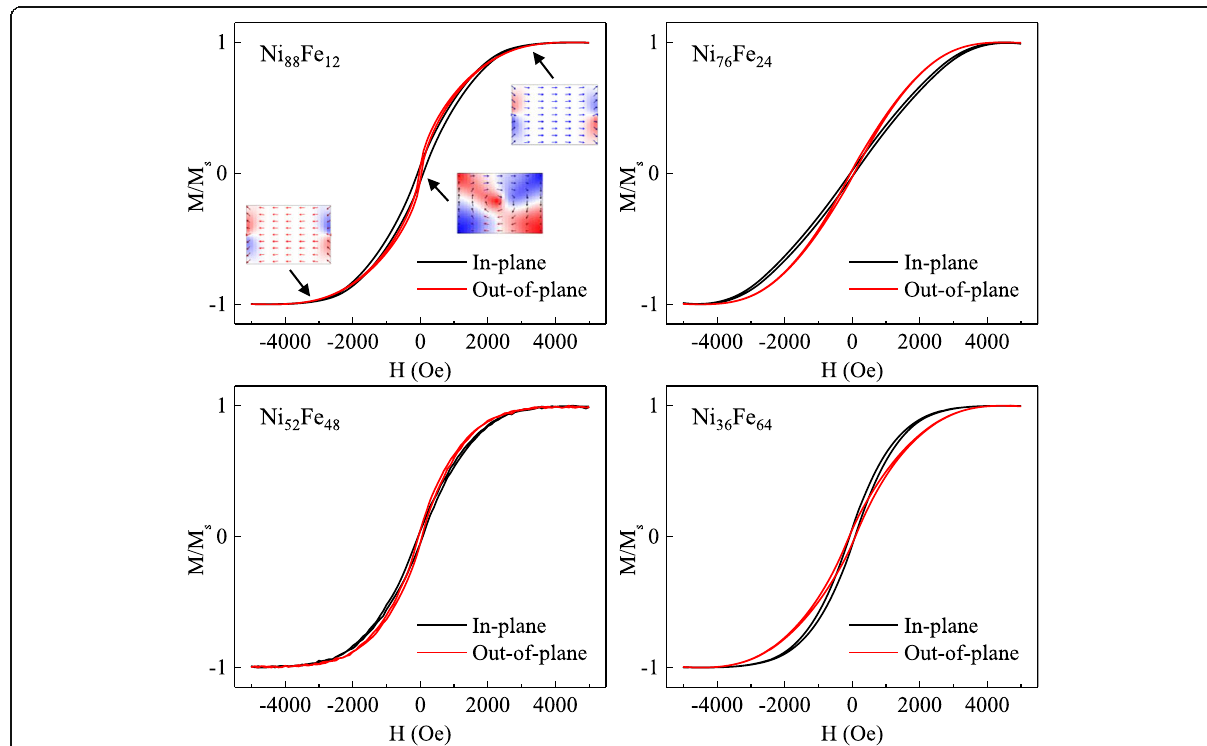
Fig. 1 Normalized hysteresis loops of NiFe MNPs for Ni 88 Fe 12 , Ni 76 Fe 24 , Ni 52 Fe 48 , and Ni 36 Fe 64 measured in the in-plane and out-of-plane directions. Insets show the magnetization configurations of the MNP at various magnetic field